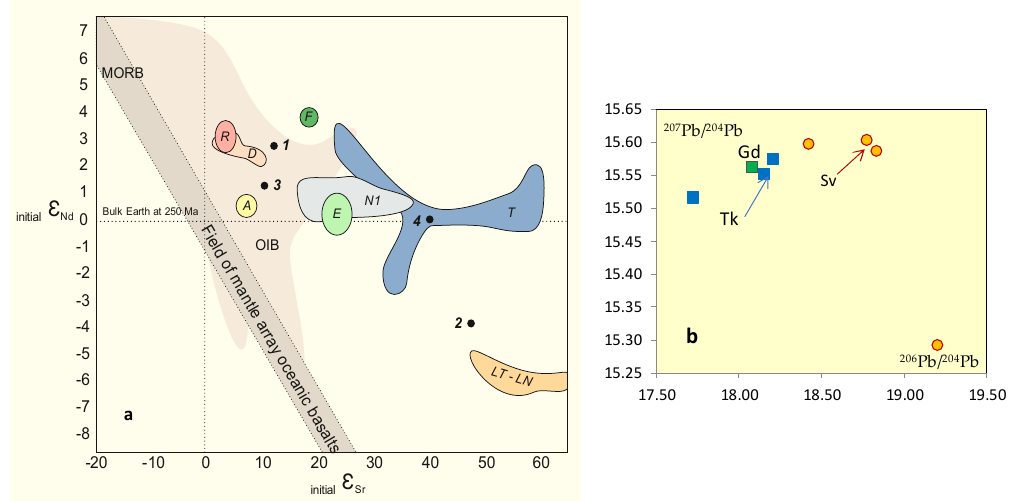
Figure 12. Initial ε Sr –ε Nd ( a ) and 206 Pb/ 204 Pb– 207 Pb/ 204 Pb ( b ) for the volcanic rocks. Formations: